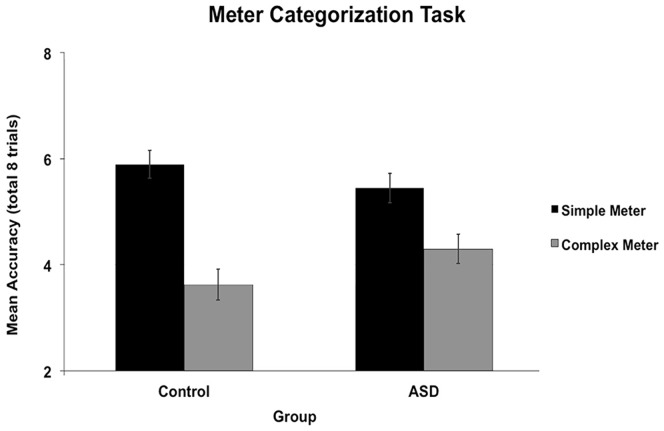
Mean accuracy for the Meter Categorization Task by group.Number correct out of 8 trials is shown on the y-axis. On each trial, it was to be determined whether an excerpt had the same or a different meter compared to a standard excerpt. Error bars represent standard error of the mean. Group differences were found such that those with ASD showed a significantly smaller difference than controls between the simple meter (typical in Western music) and complex meter (rare in Western music) conditions.